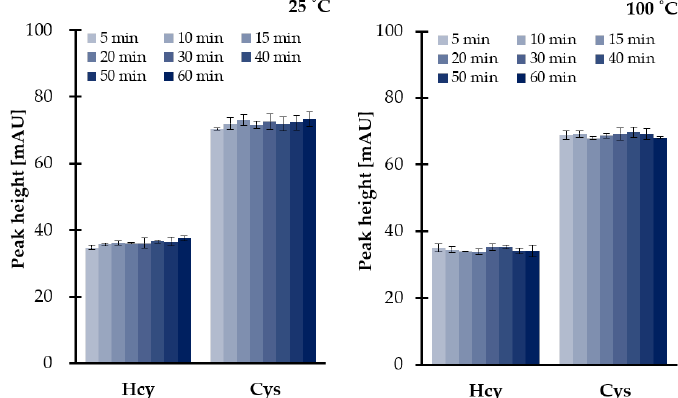
Figure 3. Influence of time and temperature on 1 mol L − 1 TCEP stability and disulfides reduction efficiency at 25 °C and 100 °C, expressed as a peak height of 2-S-lepidinium derivatives of Cys and Hcy. Samples were assayed according to the previously published method based on HPLC-UV [24]. Error bars refer to SD of the data ( n = 3).